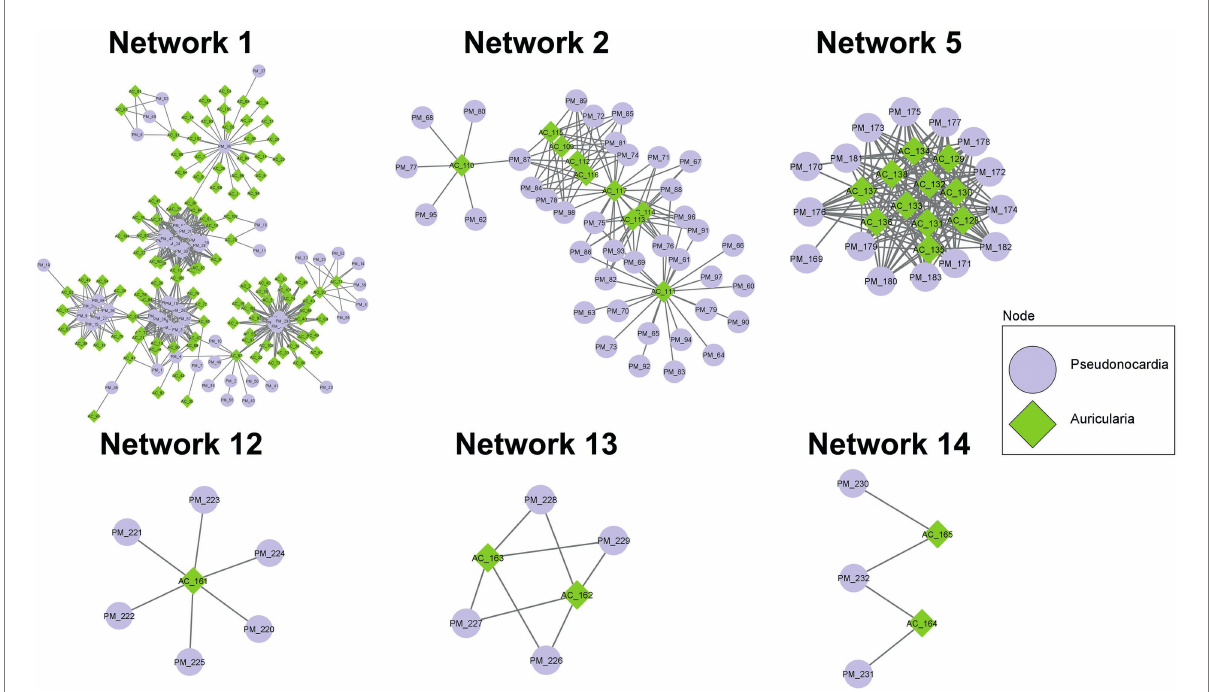
FIGURE 6 PPI networks showing possible interactions among protein domains identified from co-culture of A. cornea TBRC 12900 and P. mangrovi TBRC- BCC 42794. The 6 networks shown are those associated with BGCs known to be important for biosynthesis and transport of secondary metabolites, amino acids, polysaccharides, and lipids, as well as those involved in signal transduction. Protein domains of A. cornea origin are shown in green diamond and those of P. mangrovi origin are shown in blue